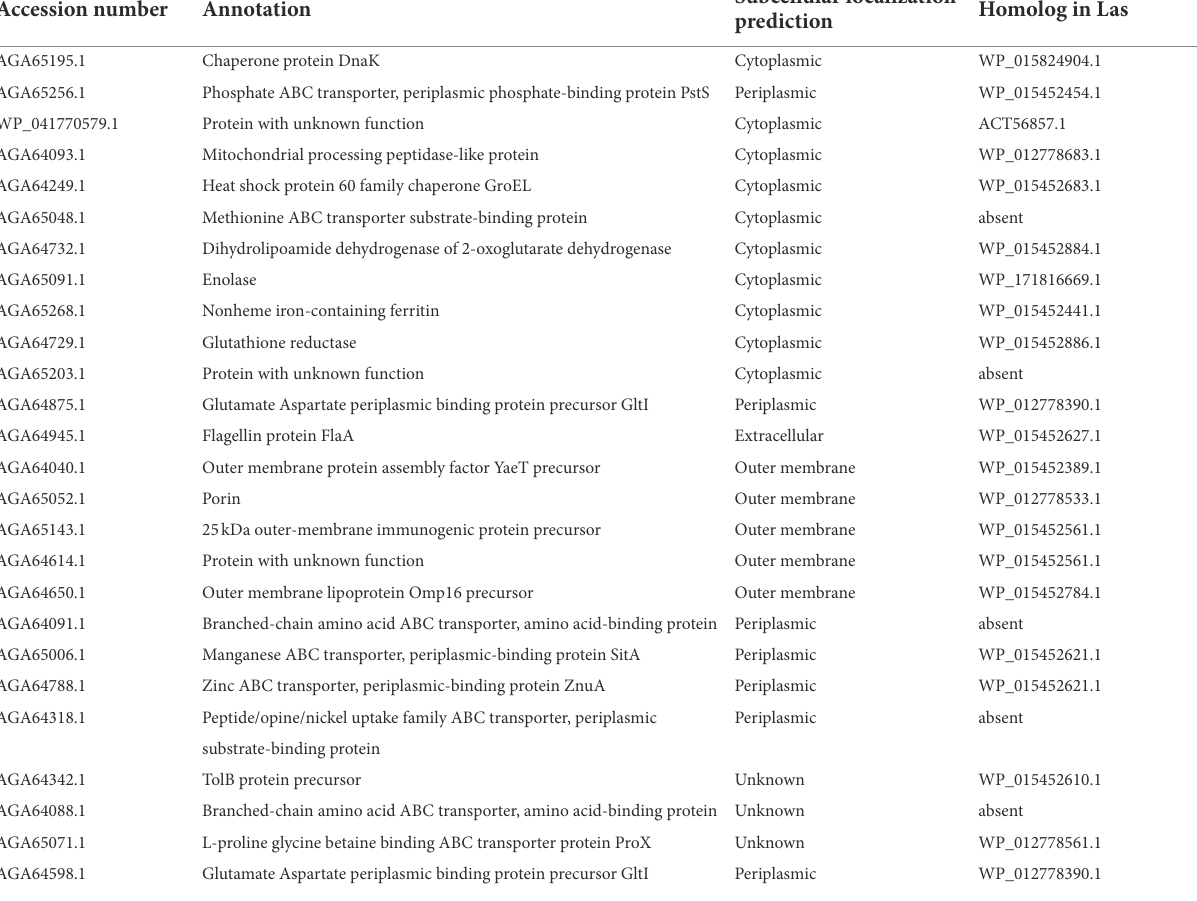
TABLE 4 Proteins identified from Liberibacter crescens BT-1 extracellular protein